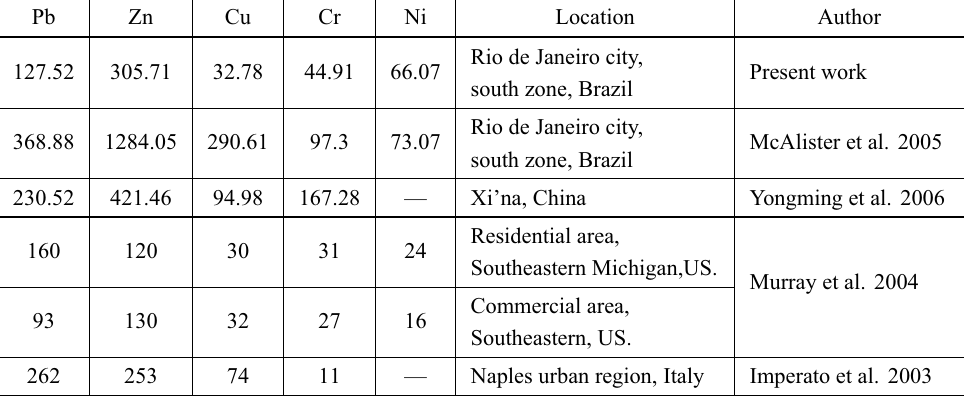
Average concentrations of heavy metals in urban dust around the world available in the